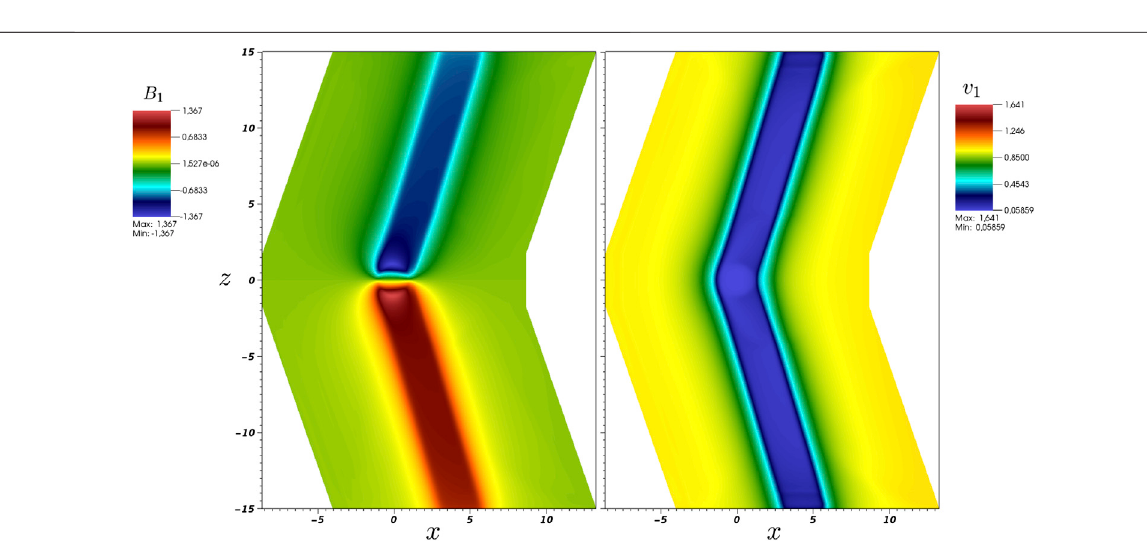
Frontiers in Physics |